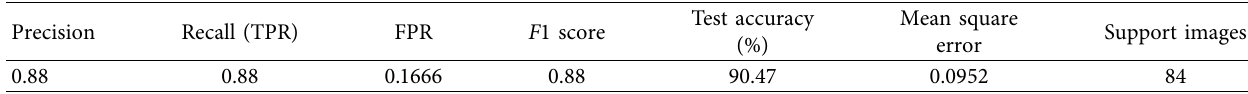
Table 8: WKNN classifer